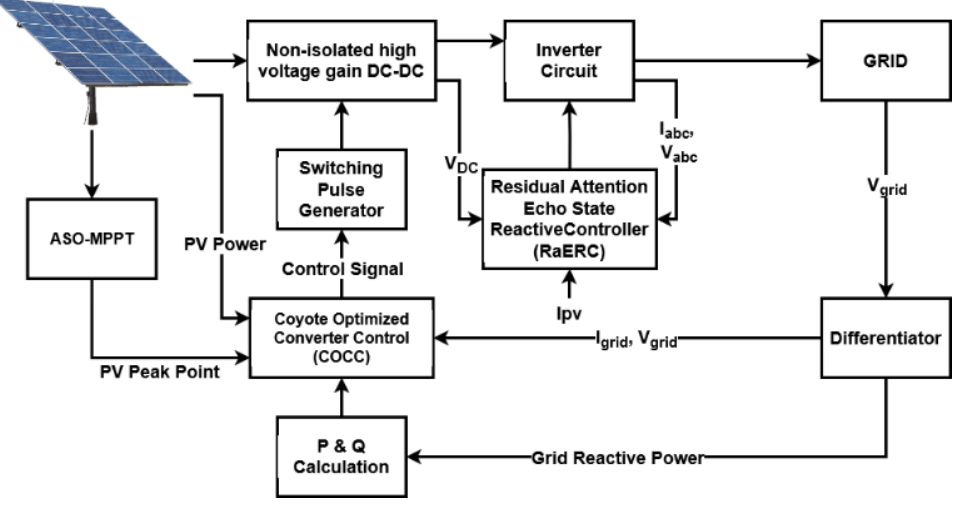
Figure 1. Working flow.